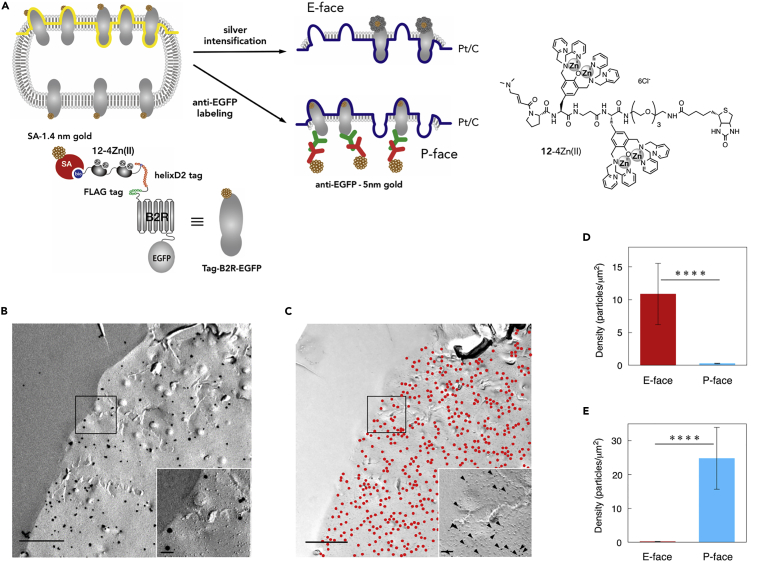
EM Detection of helixD2-Tag-Fused B2R Protein on Freeze-Fracture Replicas(A) Schematic illustration of labeling states of a complementary replica pair.(B and C) EM images of the complementary replicas showing E-face (B) and P-face (C) from the same membrane. Scale bars, 1 μm. (Insets) Magnified images of the area framed in the main pictures. Arrowheads indicate 5-nm gold particles. Scale bars, 100 nm.(D) Comparison of the labeling density of 12-4Zn(II) on the E- and P-face images, respectively (****p < 0.001, Mann-Whitney U test; E-face, n = 11; P-face, n = 9, mean ± SE).(E) Comparison of the labeling density of anti-GFP antibody on the E- and P-face images, respectively (****p < 0.001, Mann-Whitney U test; E-face, n = 7; P-face, n = 15, mean ± SE).